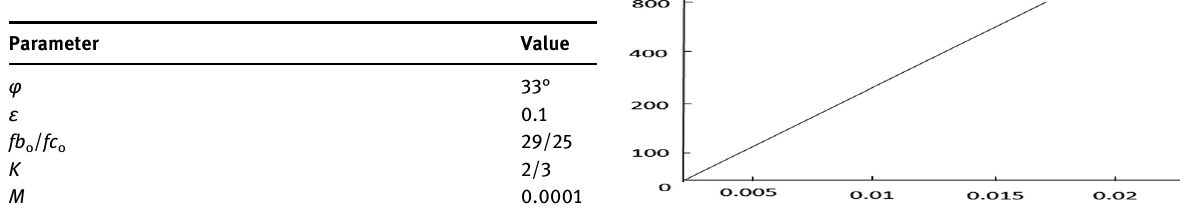
Table 2: Parameters of the CDP model used in ABAQUS